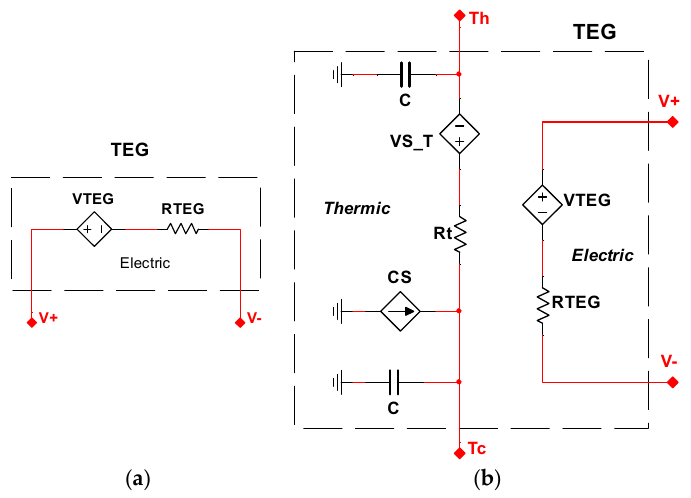
Figure 8. TEG models: ( a ) only electrical part [26]; ( b ) electric and thermal parts [24].